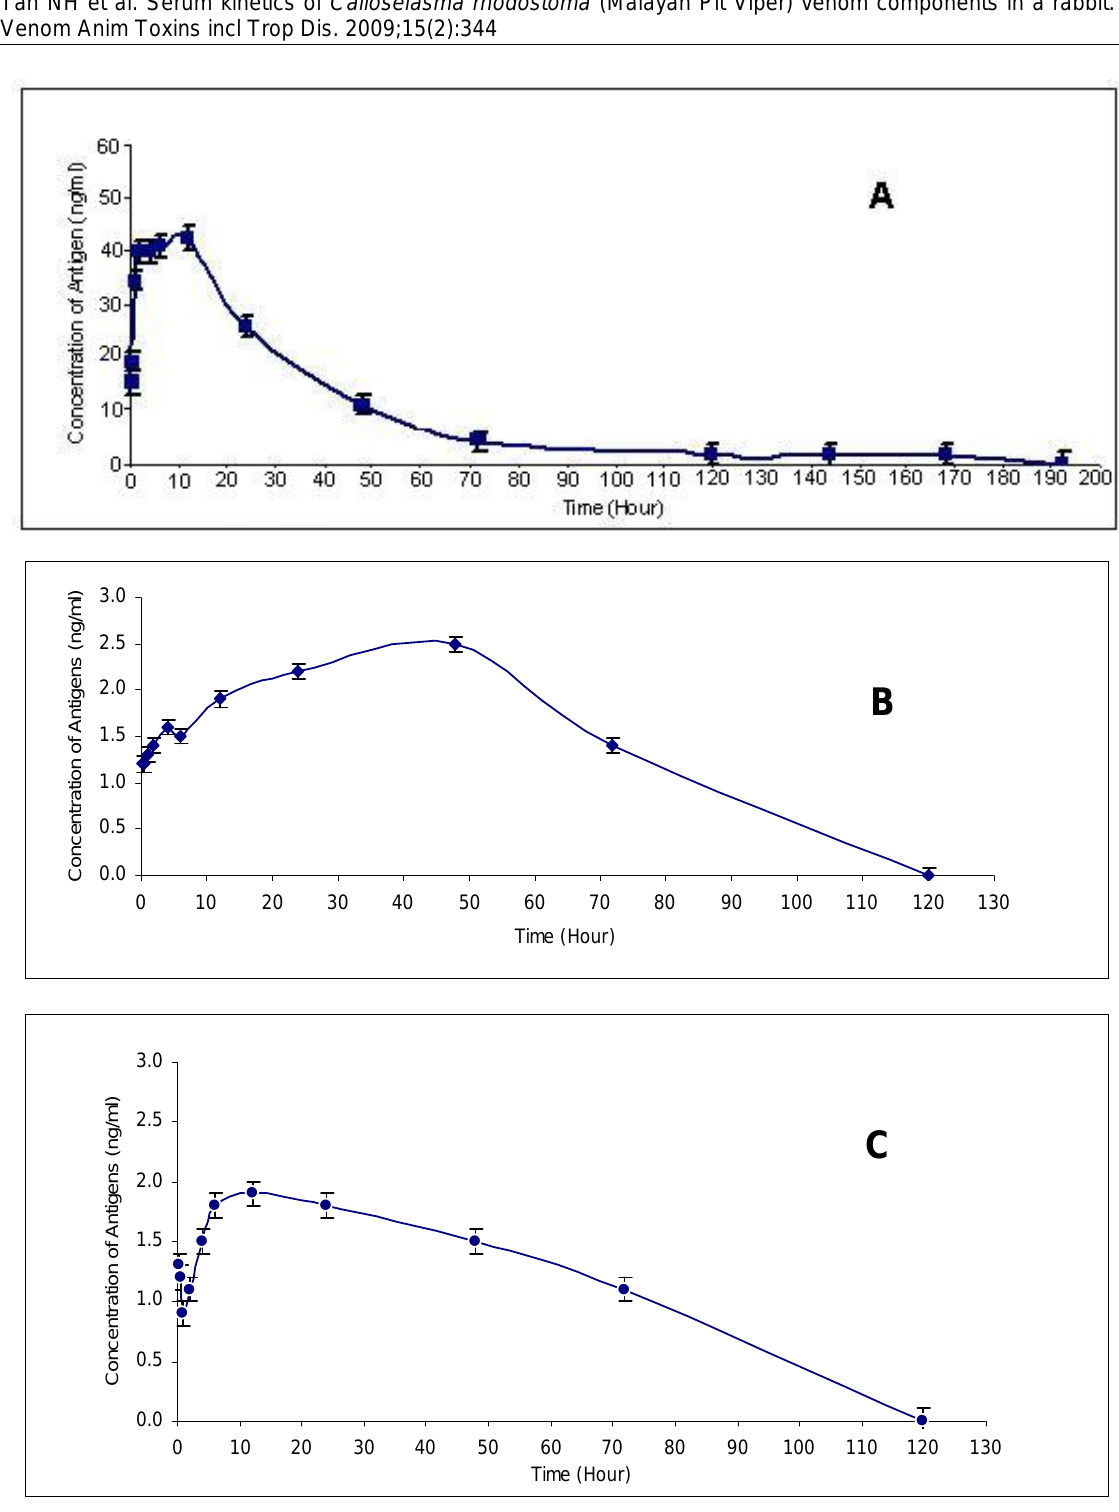
Figure 1. Serum kinetics of ( A ) Calloselasma rhodostoma venom and venom components ( B : thrombin-like enzyme; C : rhodostoxin) in a rabbit following a single intramuscular injection of a non-lethal dose of the